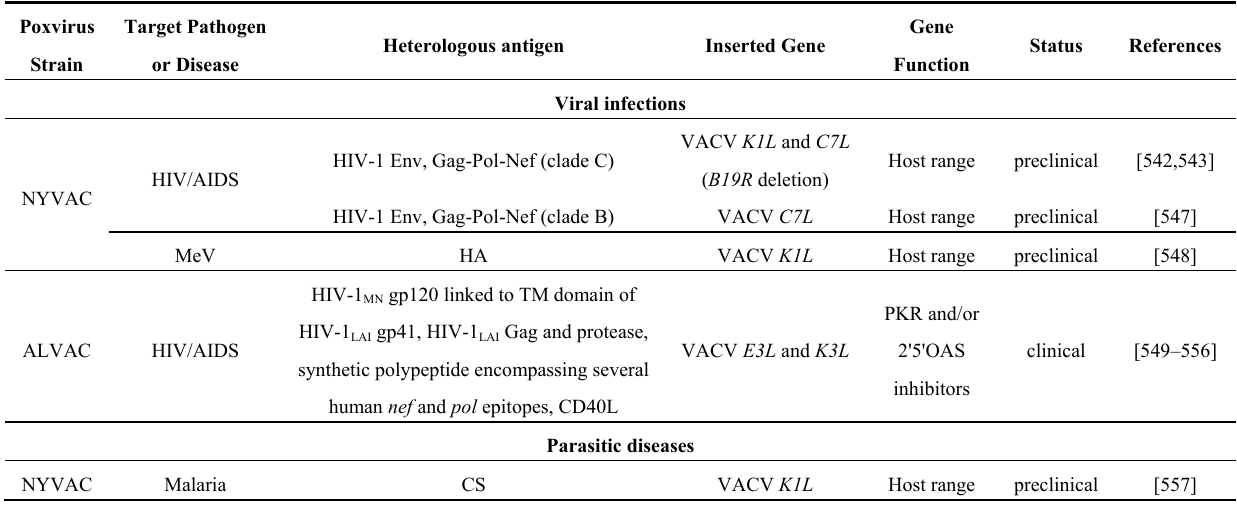
Table 10. Vaccine applications of fourth-generation poxvirus-based vectors generated by the insertion of viral